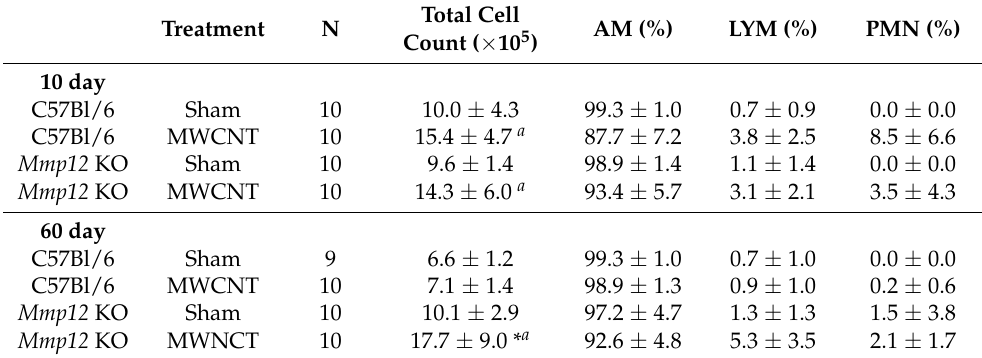
Table 2. BAL cell characteristics of C57Bl/6 and Mmp12 KO